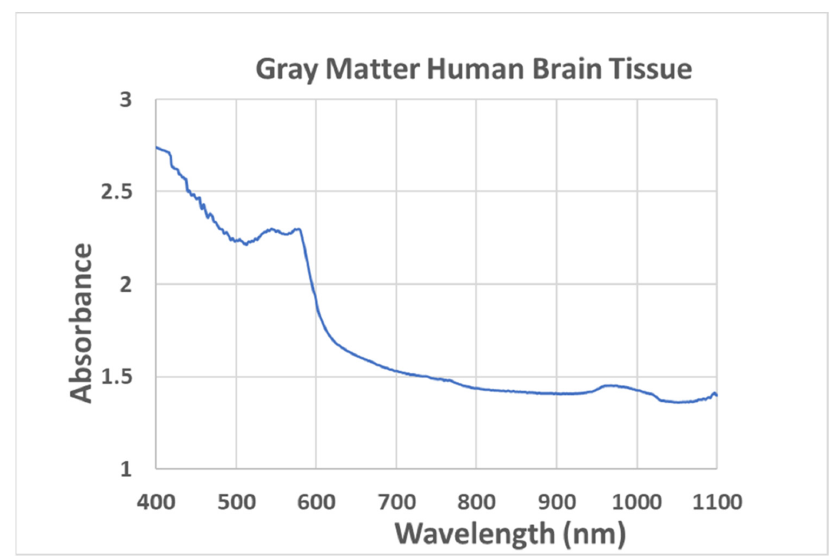
Figure 4. Absorption spectra of the gray matter of human brain tissue.